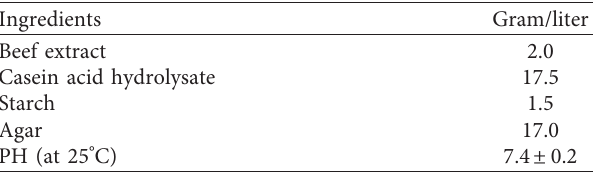
Table 8: Ingredients in gram/liter used in the preparation of Mueller–Hinton agar (MHA).